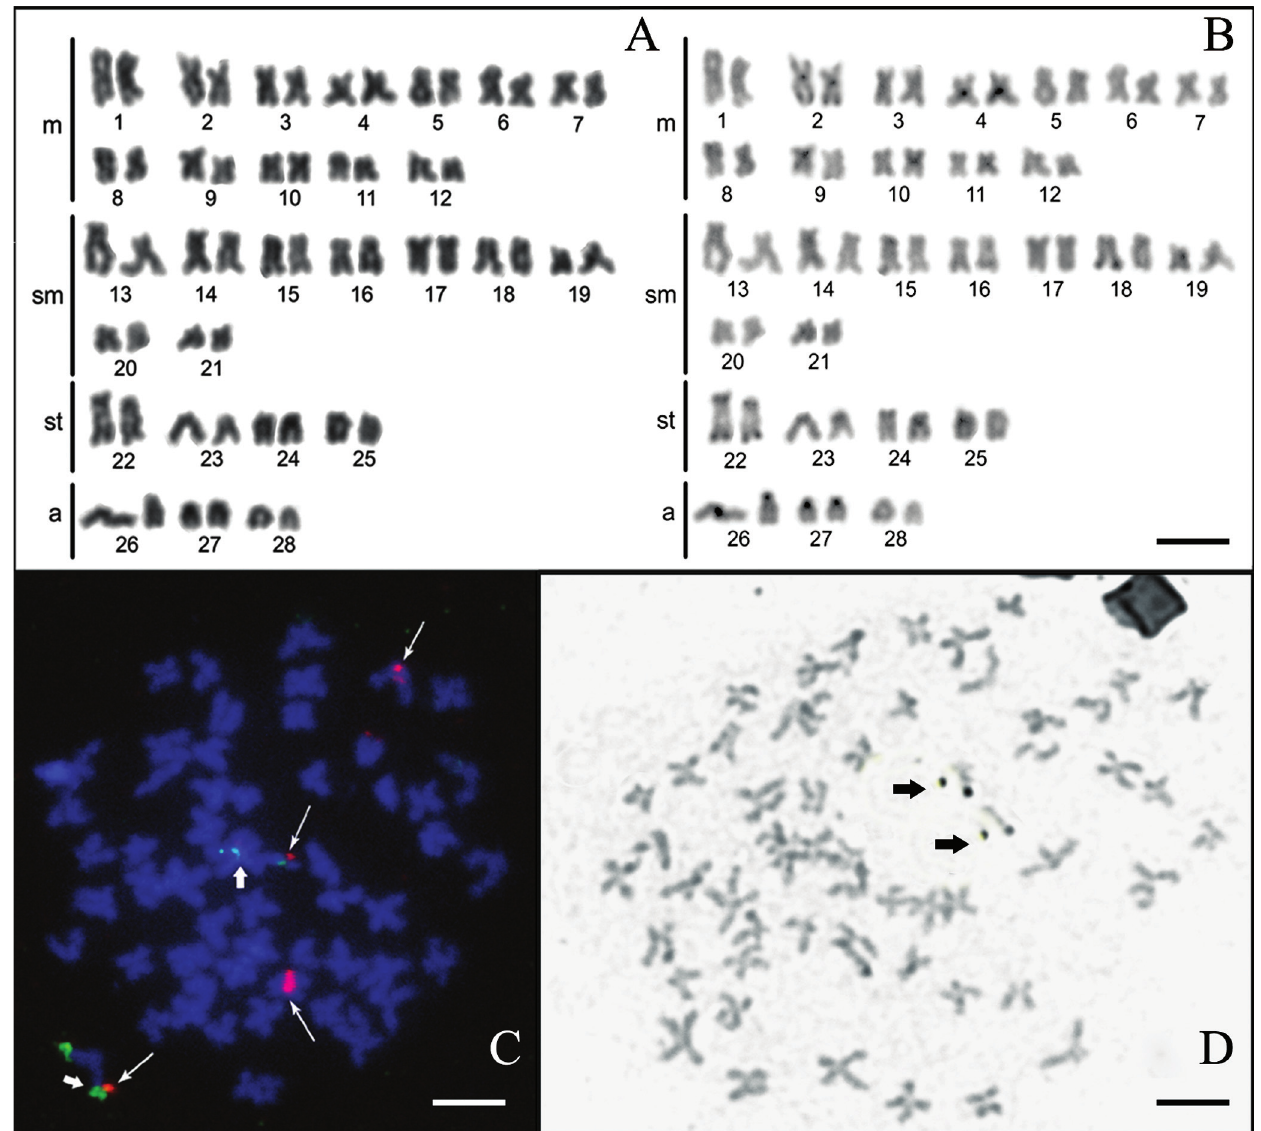
Fig. 2. Karyotype in Giemsa ( A ), C band ( B ), FISH with 18S probe (green arrows) and 5S probe (pink arrows) ( C ) and Ag-NORs ( D ) in Pimelodus britskii from the rio Iguaçu (PR). m = metacentric; sm = submetacentric; st = subtelocentric; a = acrocentric. Scale bars = 10 μ